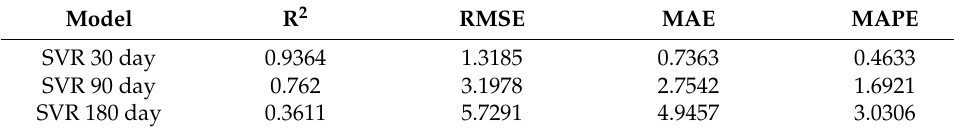
Figure 6. SVR reservoir level prediction results for 30, 90, and 180 days. Table 4. SVR 30, 90, 180 days prediction and evaluation of reservoir water level.